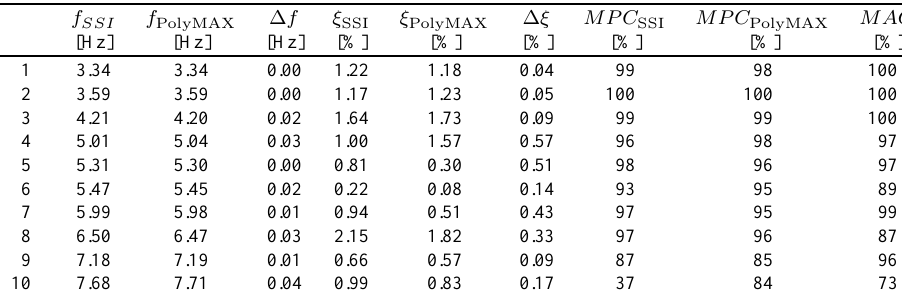
Table 3 Comparison of modal parameters from PolyMAX and Stochastic Subspace Identification (SSI).Eigenfrequencies ( f ) and damping ratios ( ξ ) for both sets are given as well as their differences ( ∆) . MPC stands for “mode phase colinearity” and expresses the complexity of a mode shape. MAC stands for “modal assurance criterion” and equals the squared correlation between two mode shapes.